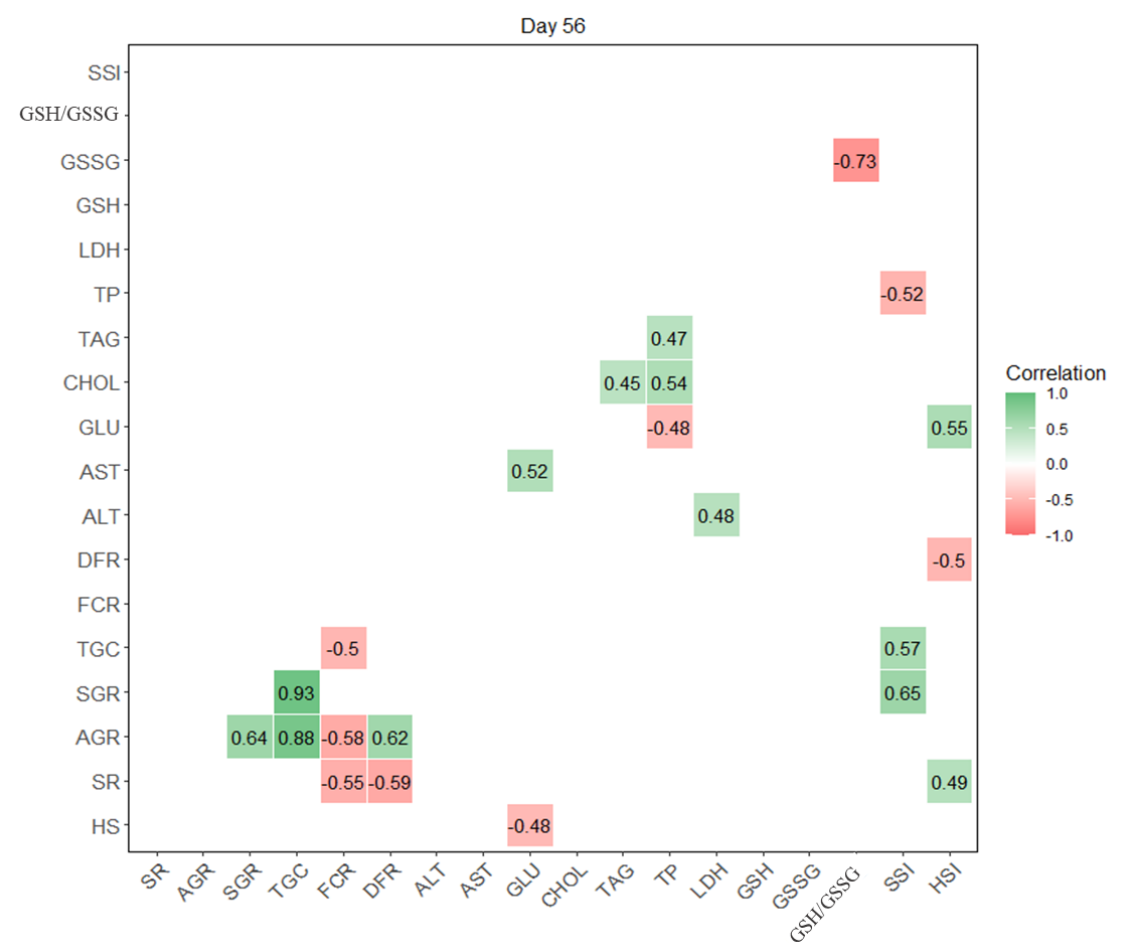
Figure 1. Correlation matrix between HS diets (0, 1, 3, 6%), growth (AGR, SGR, TGC), production (SR, FCR, DFR), biochemical (ALT, AST, GLU, CHOL, TAG, TP, LDH) and antioxidant (GSH, GSSG, GSH/GSSG) parameters and somatic indices (SSI, HSI) after 56 days of feeding. Negative correlations are coloured in red, and positive are in green, with a scale from – 1 to +1 with 0 representing the absence of correlation (no colour in figure). Correlations are assessed as strong (positive > 0.7, negative ˂ − 0.7), moderate (±0.5 to ±0.7), weak (±0.3 to ±0.5), and very weak (0 to ±0.3).